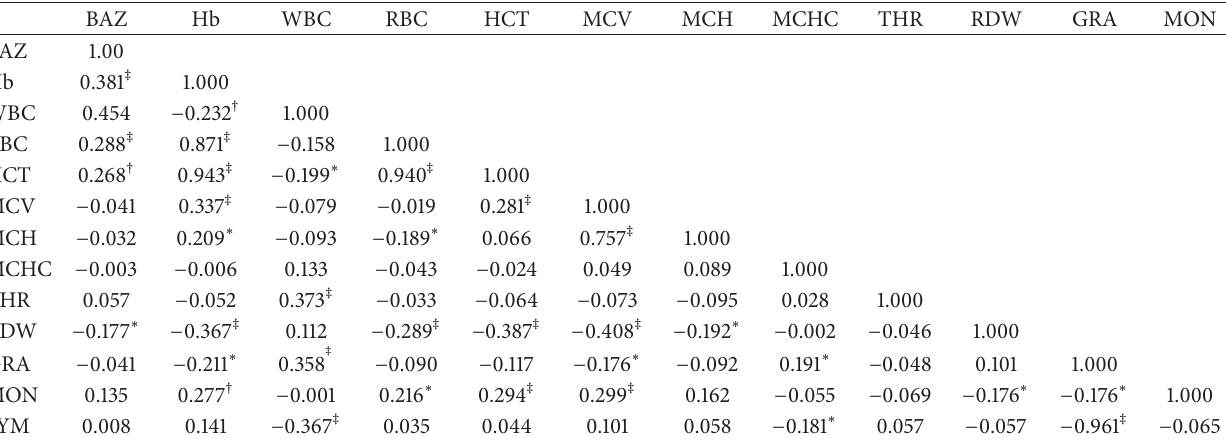
Table 7: Pearson’s correlation coefficients ( 𝑟 ) of different parameters in children of Odisha,